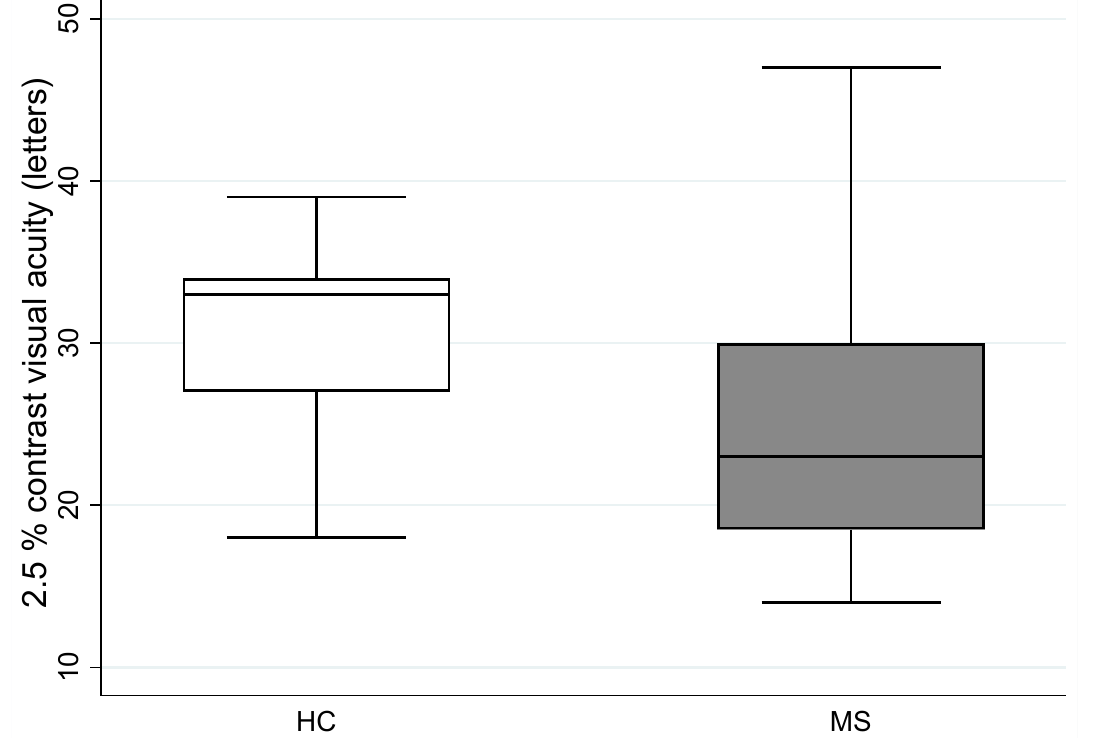
Figure 2. Box chart of 2.5% contrast visual acuity (letters) in the left eye between the healthy controls (HC) and MS patients’ groups. Data presented are in the form of median (IQR, Interquartile range). HC: Healthy Controls; MS: Multiple sclerosis, p < 0.05.